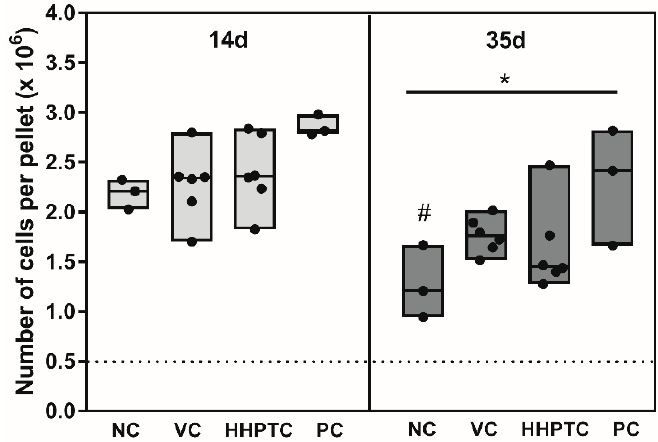
Figure 5. Number of cells per pellet after 14 and 35 days of cultivation: at day 14 and 35 of cultivation number of cells per pellet was determined using CyQuant ® Assay. Number of chondrocytes per pellet at day 14 ( left ) and day 35 of cultivation ( right ) di ff ers between used media groups. The following media groups were tested: Negative control (NC), vital cartilage conditioned medium (VC), high hydrostatic pressure treated cartilage conditioned medium (HHPTC) and positive control (PC). The dotted line depicts the initial number of cells. Solid lines within boxes show the median, minimum and maximum, while dots represent the single values. Biological duplicates were used ( n = 6). Significance was calculated with Repeated Measures Two-way ANOVA with “time” (14 and 35 days) and “treatment” (NC, VC-CM, HHPTC-CM and PC) as variables. Significance: * p < 0.05 between treatments and # p < 0.05 comparison between day 14 and 35.